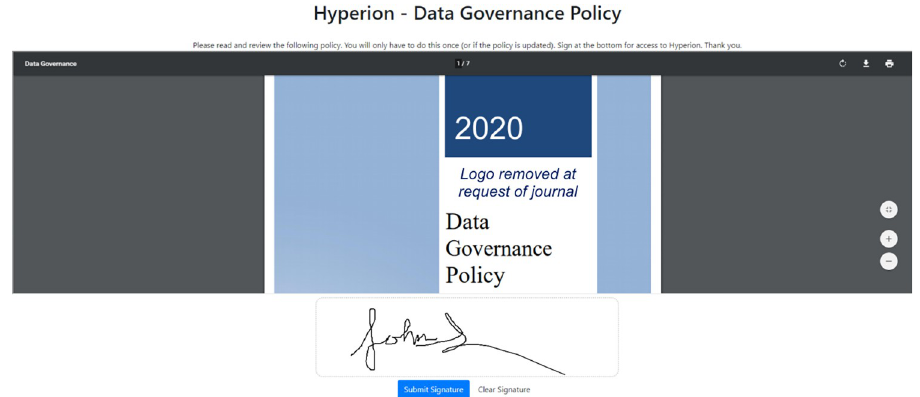
Fig 4. Custom electronic signature platform presenting the data governance policy at login.